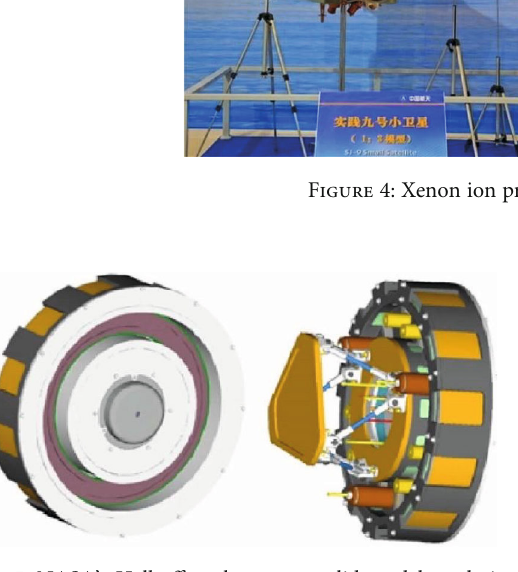
Figure 5: NASA ’ s Hall-e ff ect thruster: a solid model rendering of NASA-457M V2